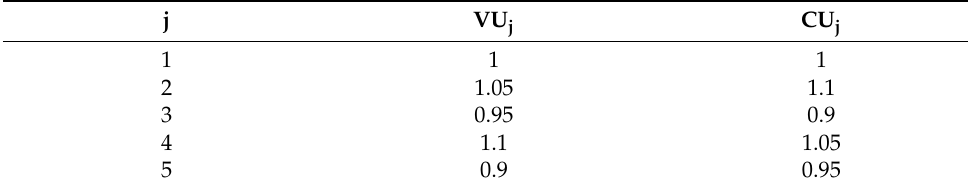
Table 1. Factors used to express voltage and current unbalance.